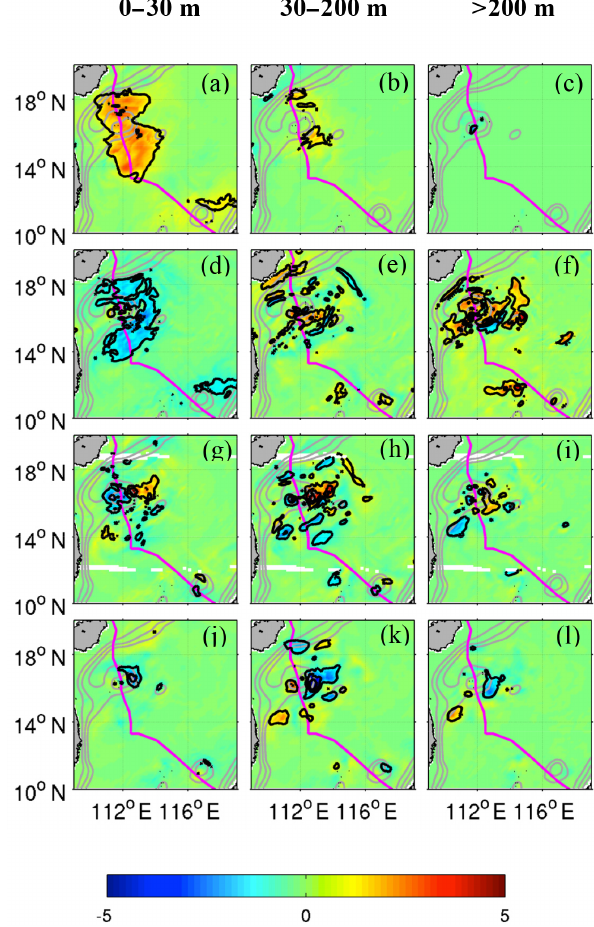
Figure 13. Horizontal distribution of time-averaged (15 April–5 May) depth-integrated KEni budget in different layers: 0–30m (left column), 30–200m (middle), and > 200m (right). The terms repre- sented are (unit: × 10 − 3 Wm − 2 ) (a–c) VVISC, (d–f) PRES, (g–i) NL h , and (j–l) NL v